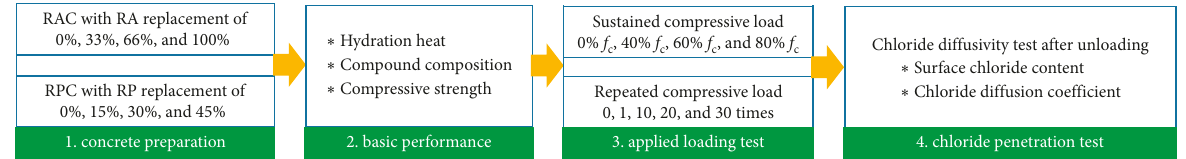
Figure 1: Flow chart of the chloride diffusivity test for RAC and RPC with preload damage.